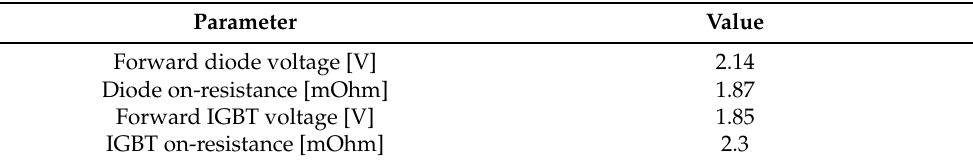
Table 2. SKiM459GD12E4 parameters for the PLECS model.